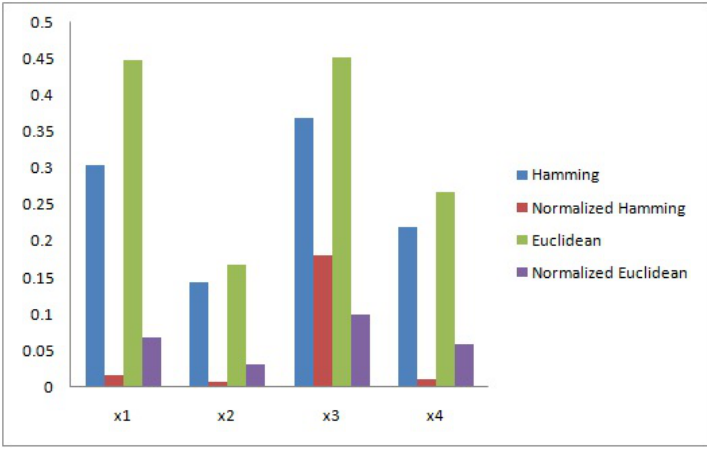
Figure 1. Weighted distance measure results on CIFSL - G